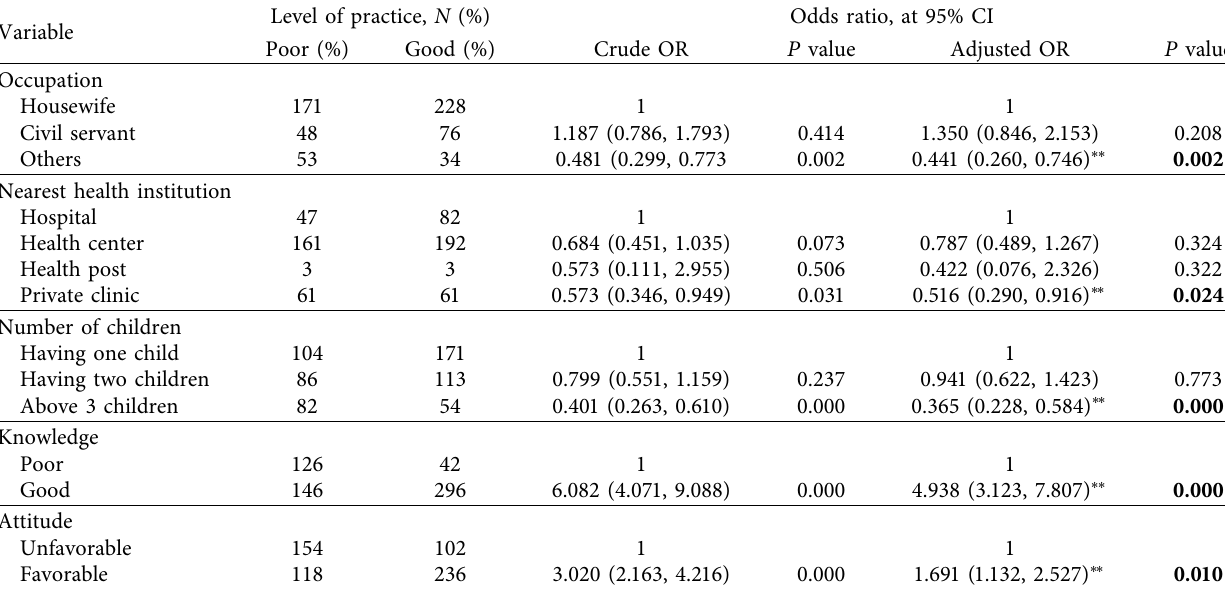
Table 8: Factors associated with the practice of mothers on COVID-19 preventive measures in Dessie town, Ethiopia,